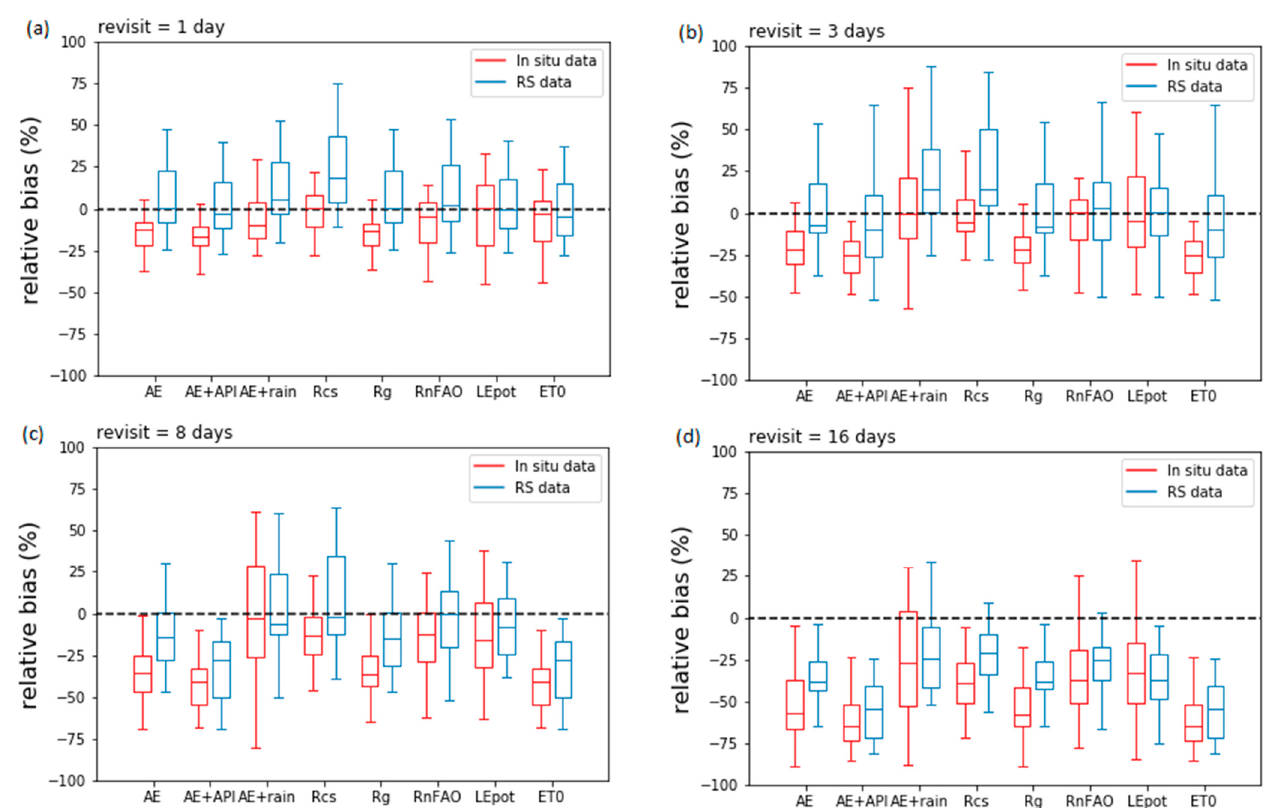
Figure 3. Relative bias (%) between observed seasonal ET and reconstructed seasonal ET for each reference quantity and ( a ) 1-day revisit frequency, ( b ) 3-days revisit frequency, ( c ) 8-days revisit frequency and ( d ) 16-days revisit frequency, using in-situ data ( red ) and remote sensing estimates ( blue ). Each boxplot presents the statistical results over the different crop cycles.